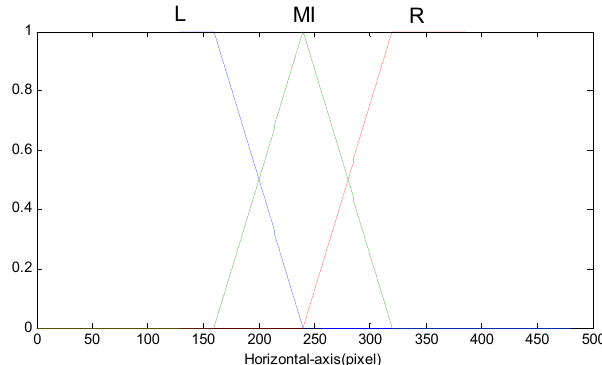
Figure 6. The flowchart of dynamic tracking.